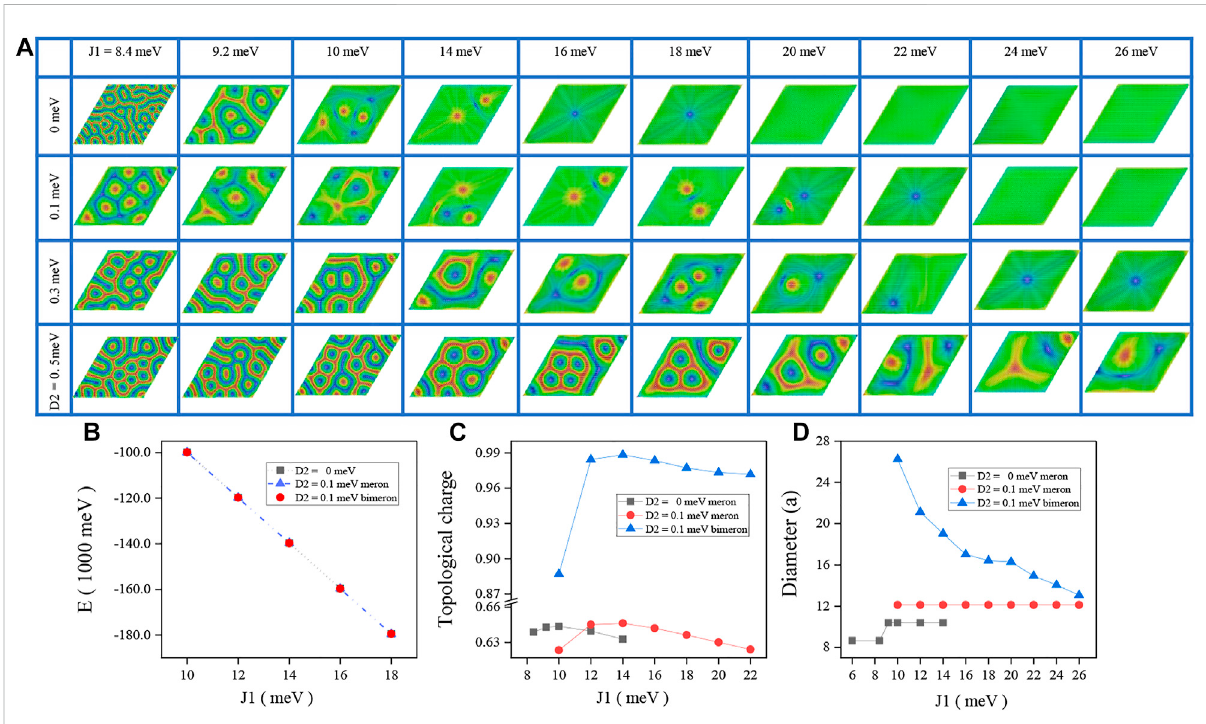
FIGURE 4 Panel (A) Spatial pro fi le of the magnetization of the fi nal state for different J 1 and D 2 with in-plane magnetic anisotropy. (B) Total energy, (C) topological charge, and (D) diameter of skyrmion as a function of the fi rst-nearest-neighbor exchange interactions J 1